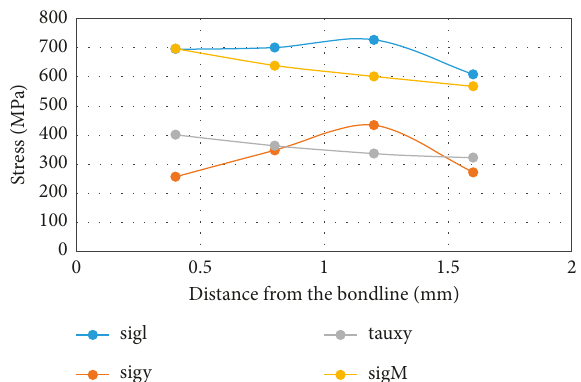
Figure 12: The dependence between maximum stresses in the joints and the distance of the impactor’s edge to the bondline (sigI (cid:136) Max Principal Stresses; sigy (cid:136) normal stresses perpendicular to the surface of the joint; tauxy (cid:136) tangential stresses in the direction of impact loading; sigM (cid:136) von Mises